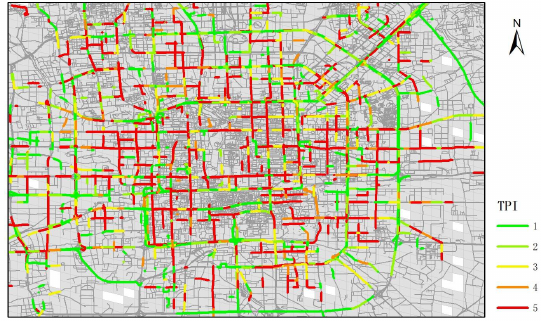
Figure 12. TPI at 16 p.m. from Monday to Thursday